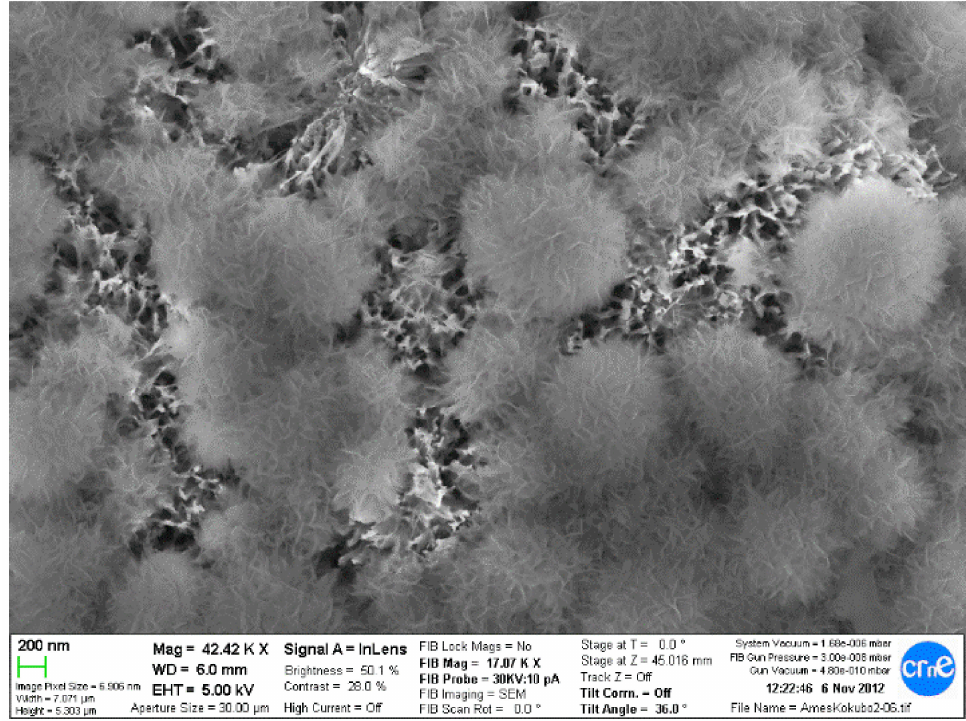
Figure 16. Titanate gel and apatites on the porous titanium